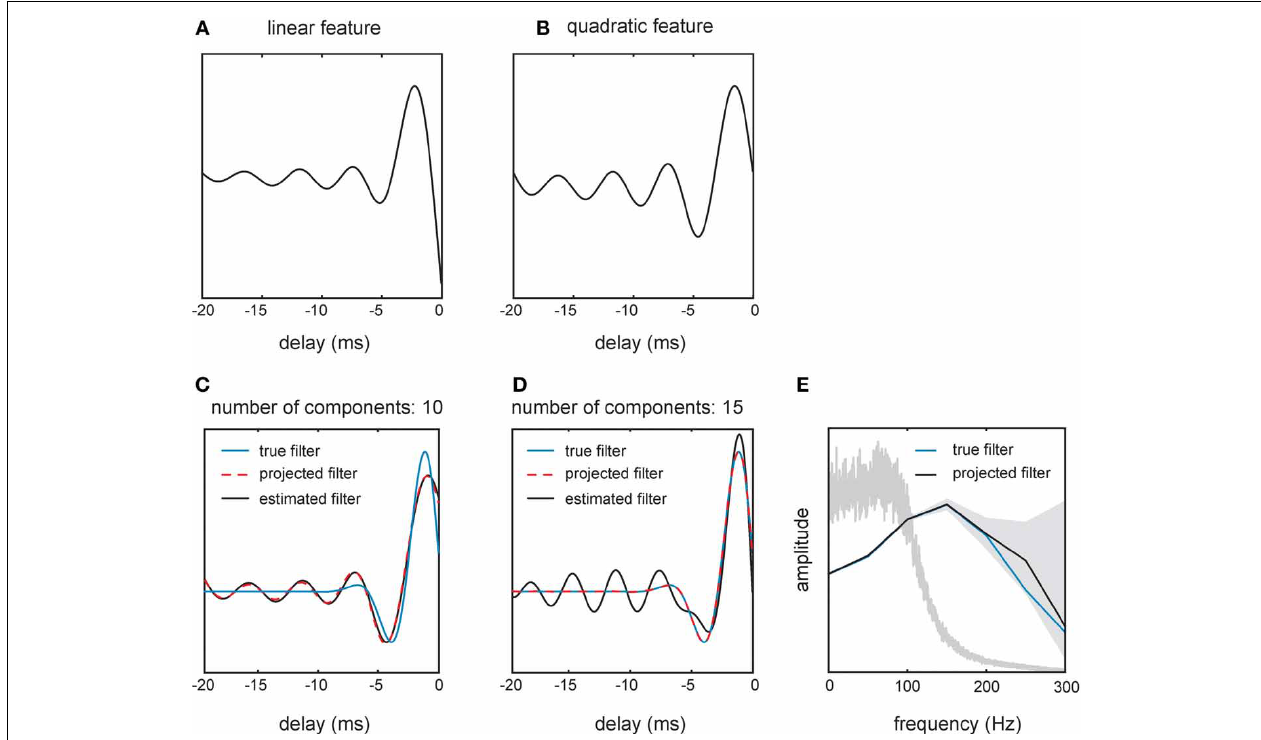
FIGURE A1 | Filter shapes estimated from spikes generated by one real and one artificial cell in response to a 100Hz filtered white noise stimulus. (A,B) show filters obtained by fitting an STM to the responses of one SA cell. (C) The stimulus filter of a toy neuron (blue line) was estimated (black line) from the model’s responses to the same stimulus as used in the experiments with real cells. Since we only used 10 principal component vectors to represent the filter, even a perfect estimate (yellow dashed line)